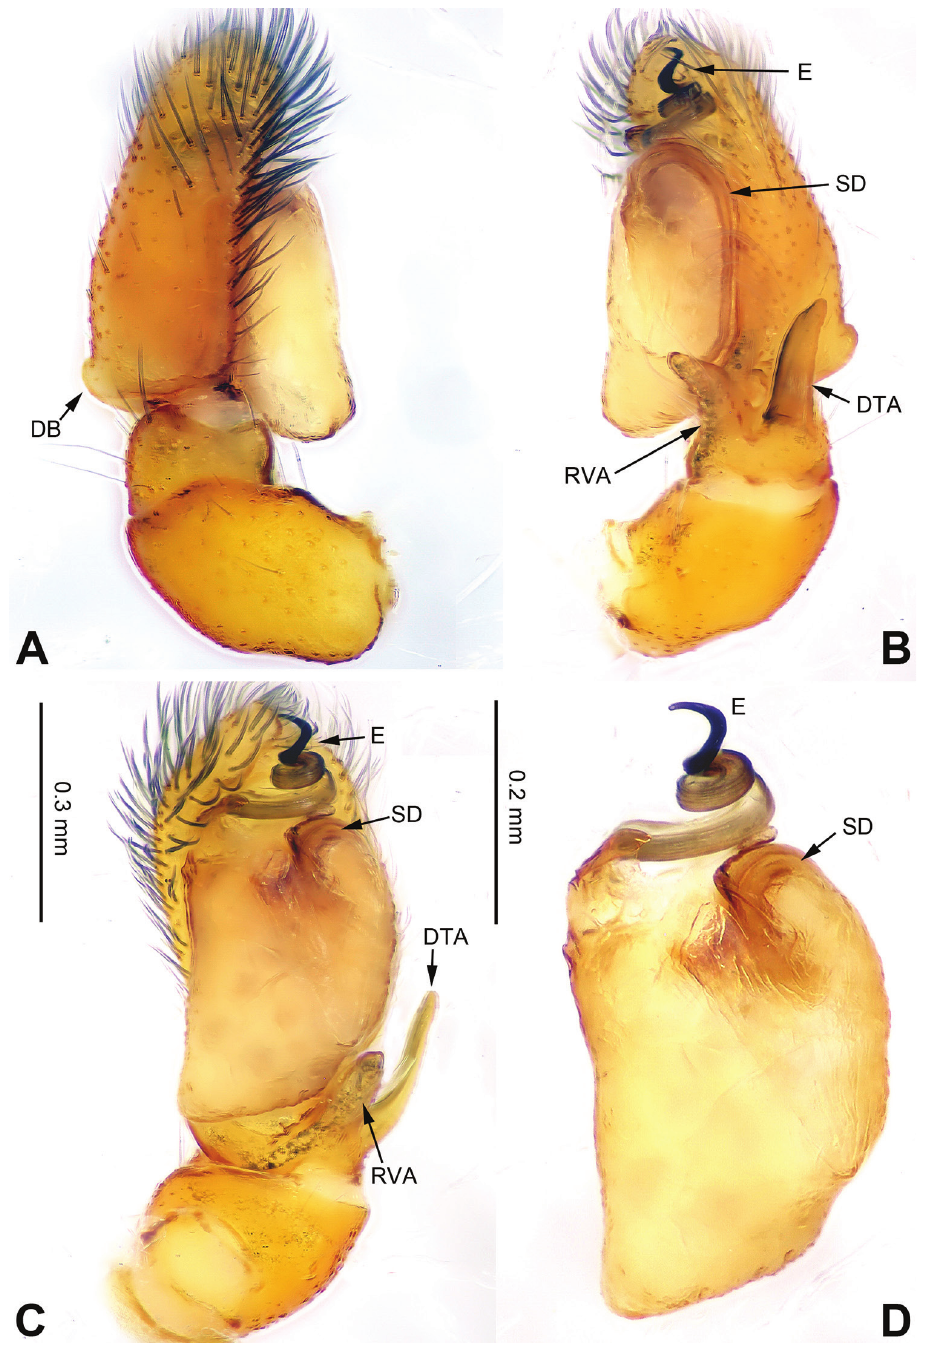
Figure 3. Palp of Agorius tortilis sp. n., male holotype. A prolateral B retrolateral C ventral D bulb, ventral. Scale bar equal for A–C